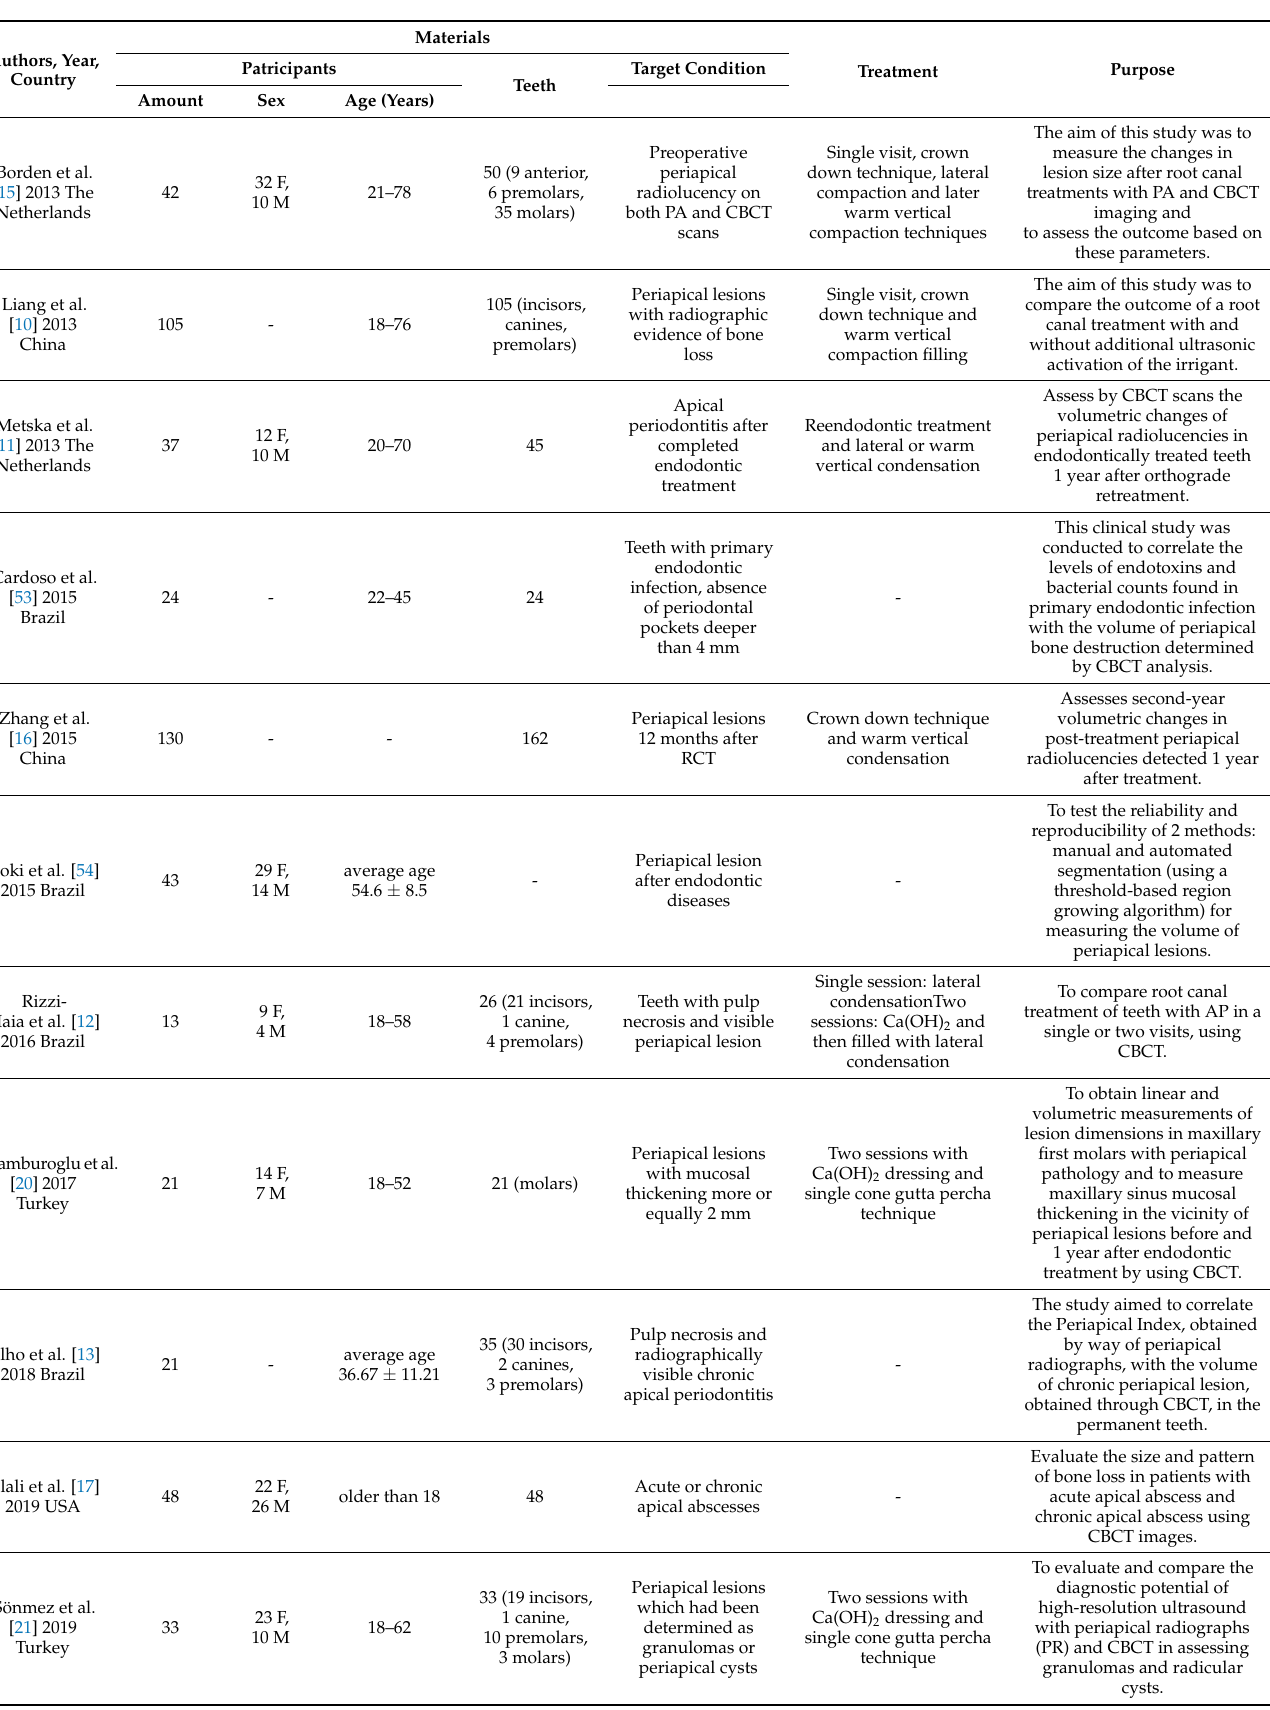
Table 2. Summarized characteristics of included